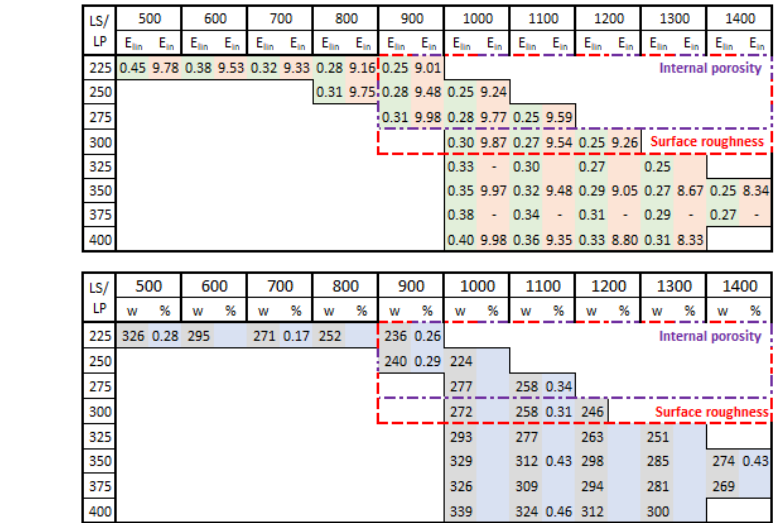
Figure 19. The perspective area ( a ) linear energy E lin (J/mm) (green cells) and input energy to the layer E in (J) (red cells); ( b ) width of single welds in (µm) multiplied × 1.25 (parameter from hollow strut test) (grey cells) and porosity level (blue cells).